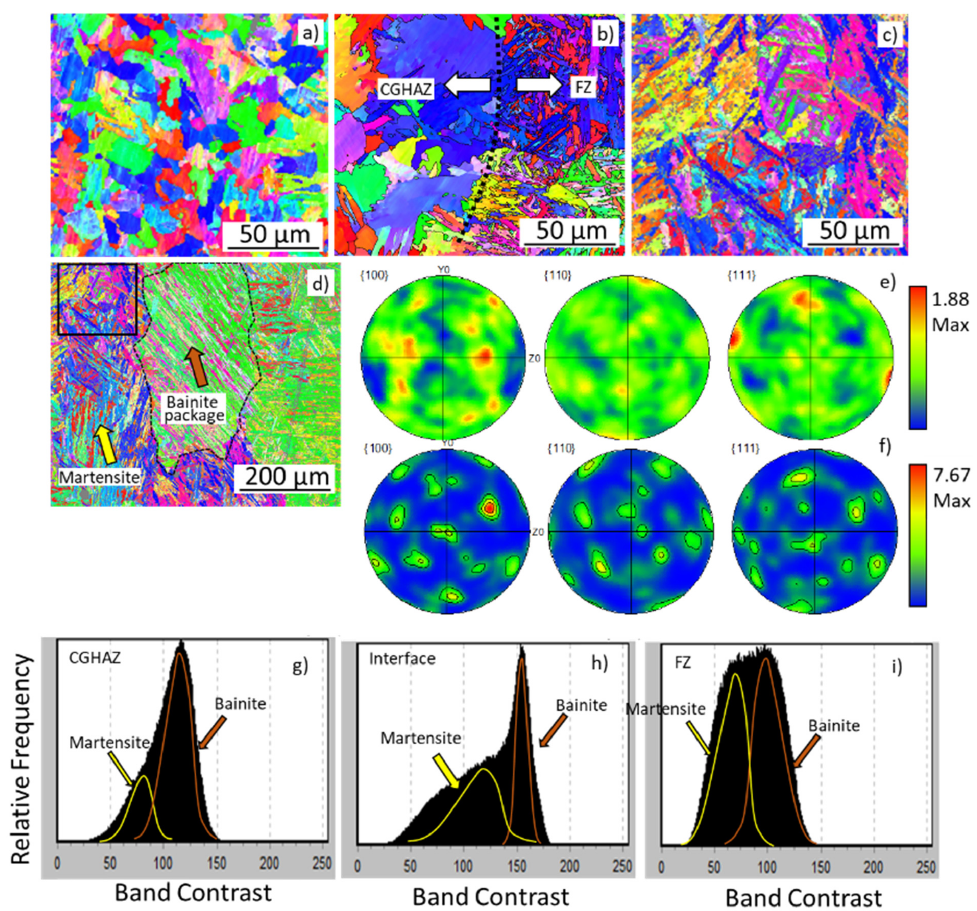
Figure 10. EBSD results of the formed metallurgical zones in the weld bead: ( a ) inverse pole figure (IPF) of the CGHAZ near fusion line; ( b ) CGHAZ and FZ interface; ( c ) high magnification of black square in ( d ); ( d ) FZ in lower magnification; ( e ) pole figure (PF) of the CGHAZ; ( f ) PF of the FZ. Band contrast (BC) with the convolution of martensite and bainite peaks for the ( g ) CGHAZ, ( h ) FZ interface, and ( i ) FZ.